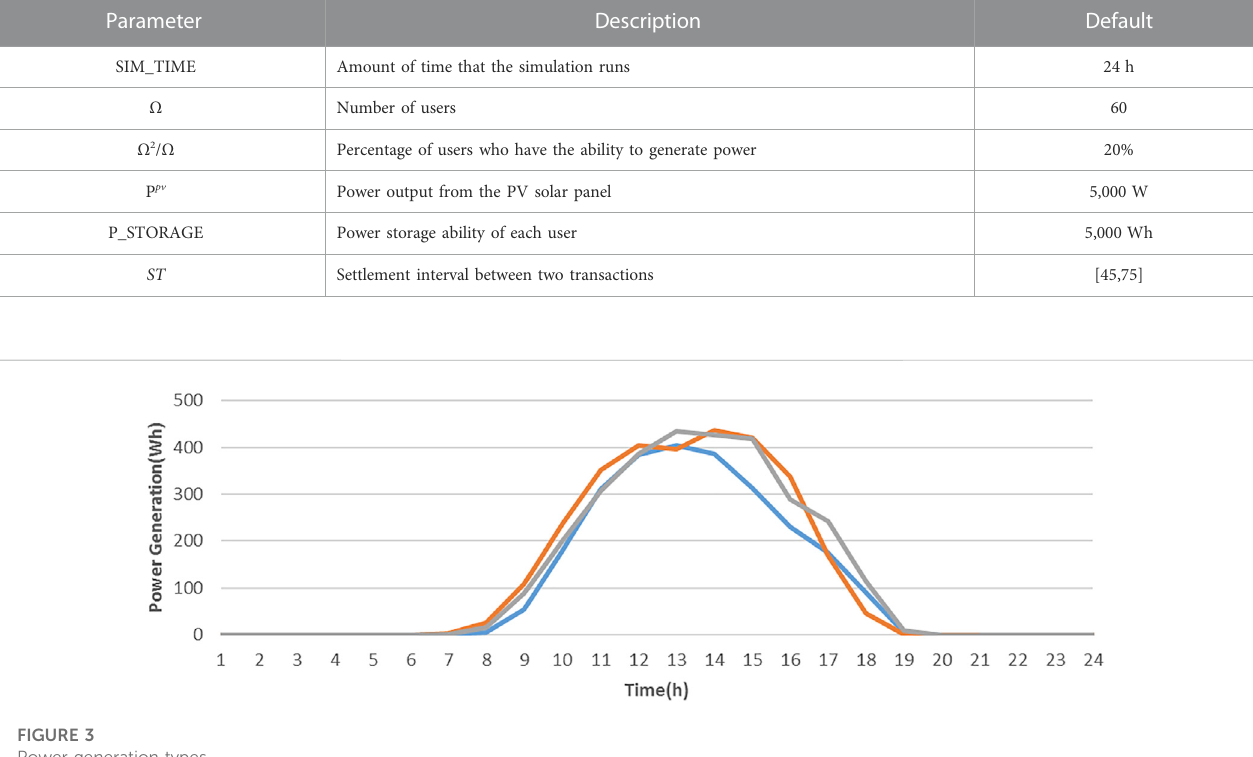
TABLE 1 Key parameters in power grid simulation.